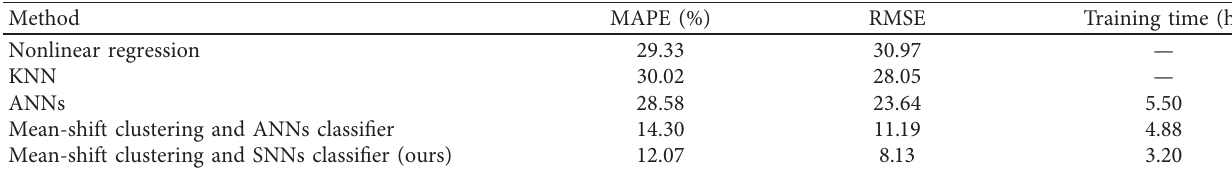
Table 6: Prediction performance comparison of clean-up